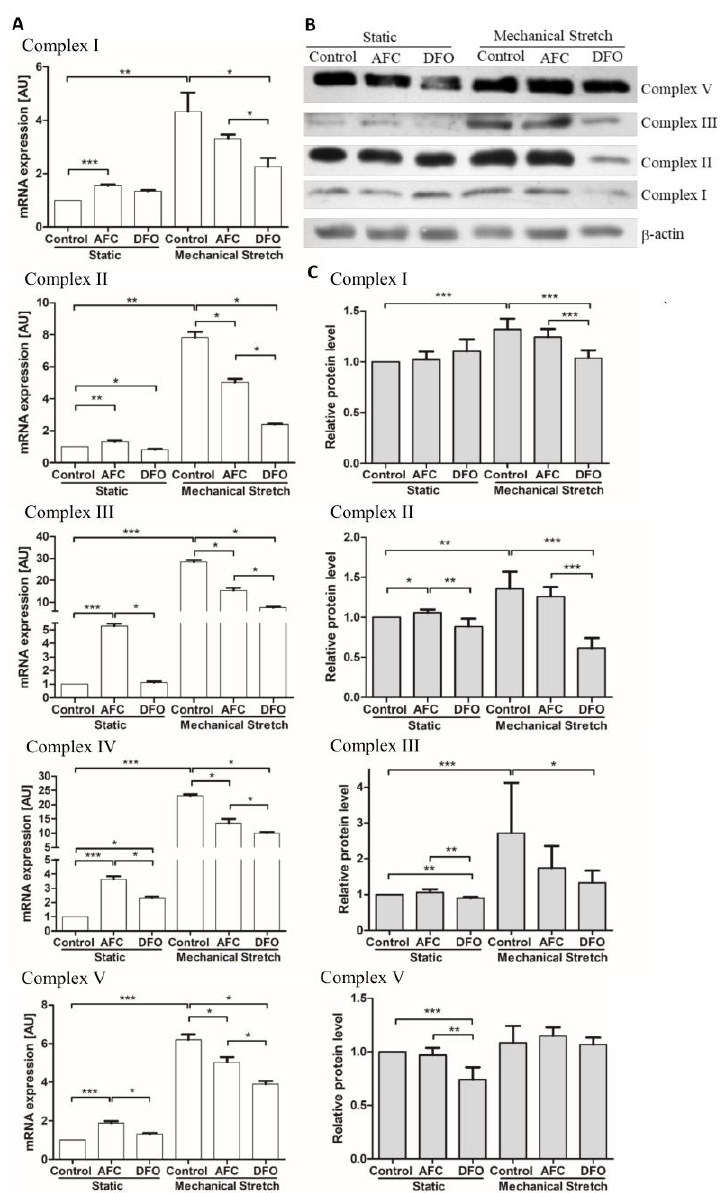
Figure 2. Expression of mitochondrial complexes in HCM cells cultured either in static conditions or upon mechanical stretch with concomitant optimal, increased or reduced iron availability. mRNA expression levels of complexes I, II, III, IV and V in HCM cells ( A ). Representative immunoblot of complexes I, II, III, V and β -actin as a loading control ( B ) and summary data showing relative protein expression in cell lysates standardized to β -actin ( C ). Complex IV was undetectable in the cell lysates. Data are presented as the mean + standard deviation obtained from three separate experiments. * p < 0.05; ** p < 0.01; *** p < 0.001. AU, arbitrary units; AFC, ammonium ferric citrate; DFO,